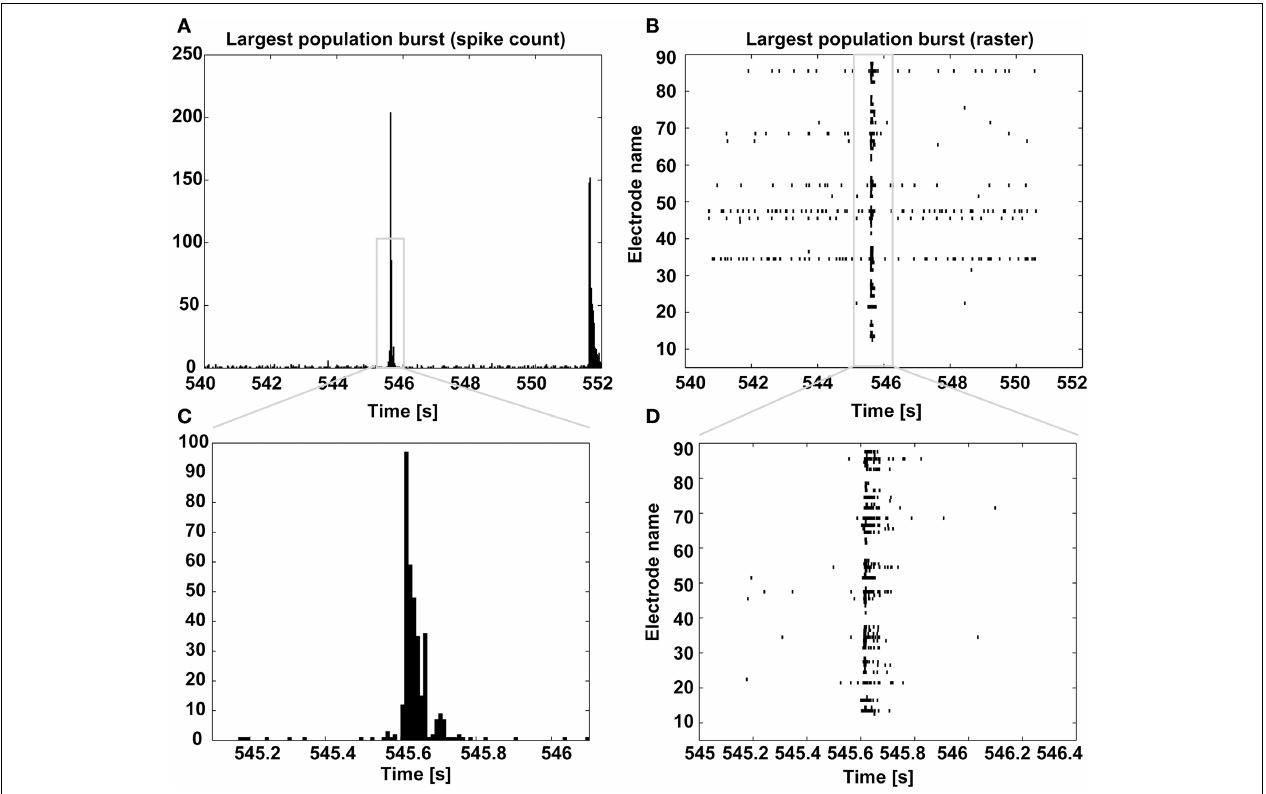
FIGURE 9 | Largest population burst. As in Figure 8 , the spike count is displayed and it is centered on the largest MEA-wide synchronization event (i.e., a burst) (A) , together with its corresponding spike raster diagram (B) , with increasing temporal resolution (C,D)